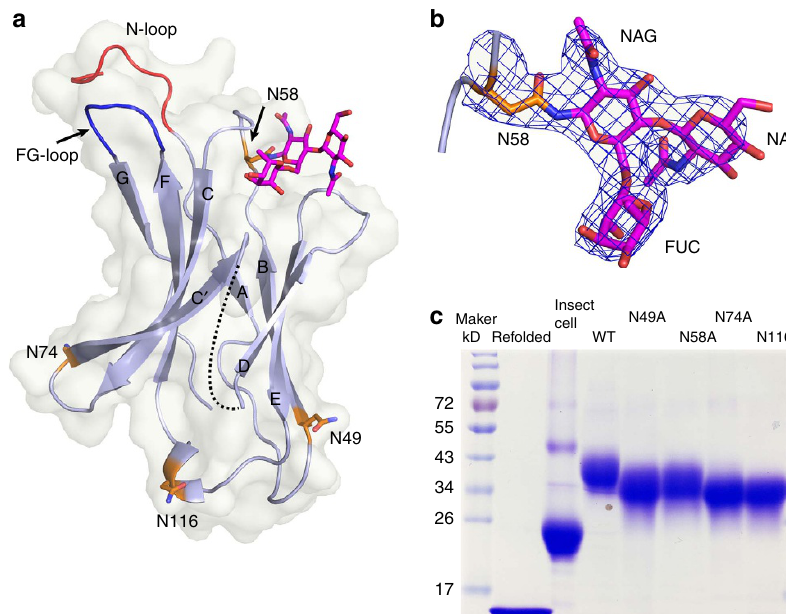
Figure 3 | Structural basis of glycan modification in PD-1. ( a ) A cartoon representation of the PD-1 structure. The four N-linked glycosylation sites (N49, N58, N74, and N116) are shown in sticks and coloured orange. The observed glycans are highlighted in sticks and coloured in magenta. ( b ) The 2 Fo-Fc electron density map of the N58 N-linked glycans contoured at 1.0 sigma is represented in blue. Three glycans consisting of two N-acetylglucosamine (NAGs) and one L-fucose (FUC) can be clearly observed. ( c ) SDS-PAGE analysis of the molecular reduction of four N-glycosylation single site-mutated PD- 1 protein and PD-1 protein expressed in insect cells or refolded PD-1 protein expressed in E. coli cells. Compared with the WT PD-1 protein, each of the four N-glycosylation single site mutations has induced various levels of molecular weight reduction, indicating the N-glycosylation on each of the sites. PD-1 protein expressed in insect cells or E. coli cells showed substantial reduction of molecular weight, indicating the heavy glycosylation of